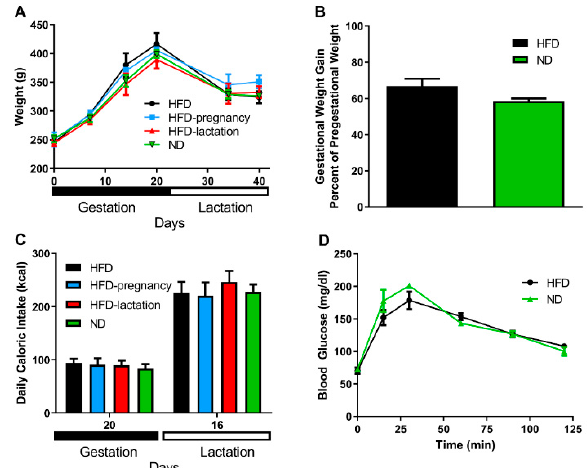
Figure 2. Maternal characteristics. Maternal body weight ( A ). HFD mothers are represented by black symbols and lines; HFD-pregnancy mothers by light blue symbols and lines; HFD-lactation group by red symbols and lines, whereas ND group of mothers were represented by green symbols and lines. Gestational weight gain ( B ). Black columns depict HFD and HFD-pregnancy dams combined; green columns: ND and HFD-lactation dams combined. Maternal daily caloric intake ( C ). Black columns represent HFD dams; light blue columns: HFD-pregnancy dams; red columns: HFD-lactation dams; and green columns: ND group of offspring. Glucose tolerance tests ( D ). Group representations were the same as in graph B, but here with symbols and lines. Data expressed as mean ± SEM. For more details and statistics, see Results.